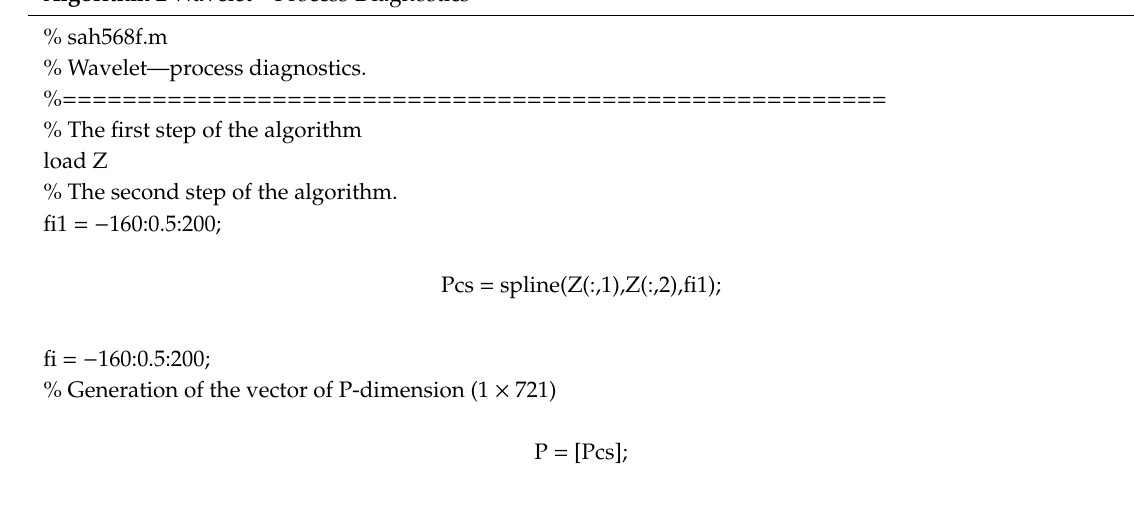
Algorithm 2 Wavelet—Process